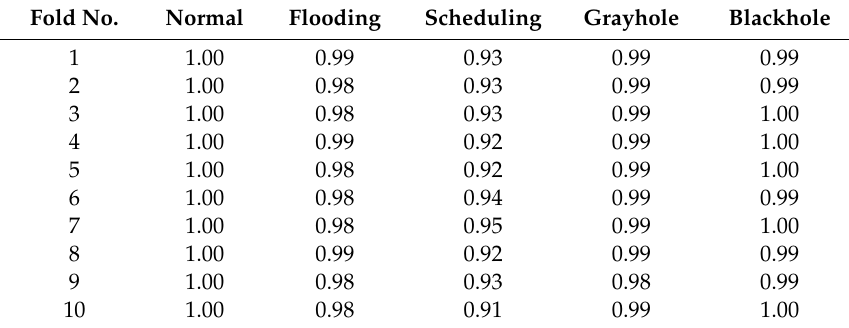
Table 5. Recall results of the 10 fold cross validation.